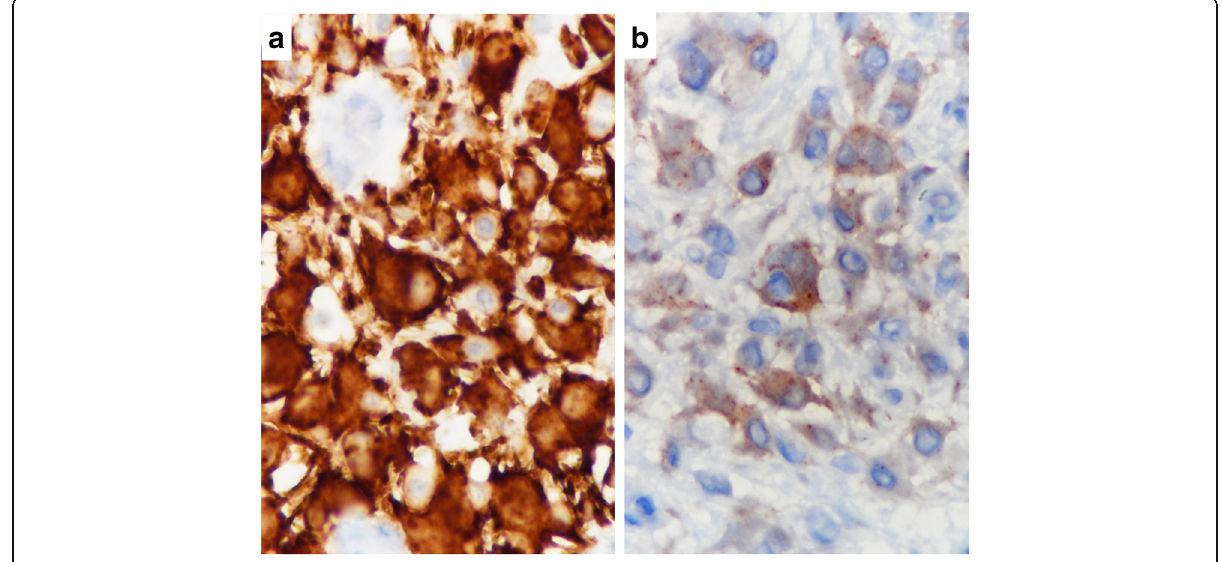
Fig. 5 Immunohistochemistry for ALK. The immunostaining was performed using both clone 5A4 ( a ) and an anti-ALK-1 antibody ( b ) and demonstrated cytoplasmic staining